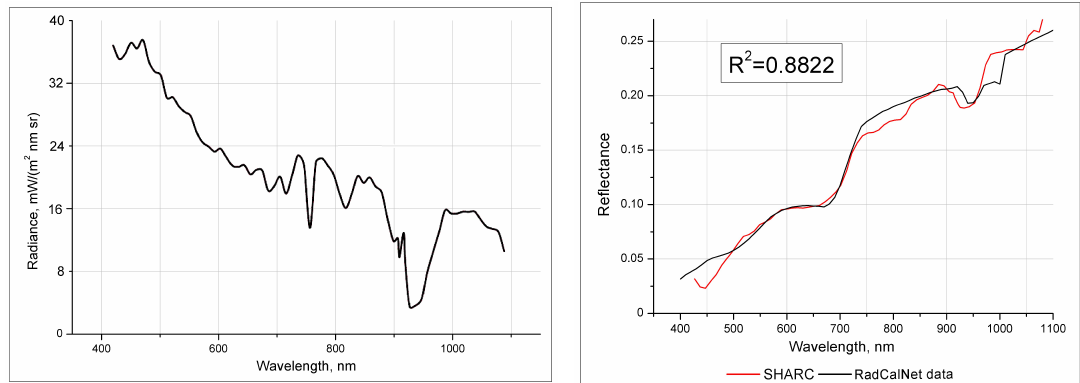
Figure 9. Hyperion radiance spectrum (left side) and measured reflectance of RadCalNet network in comparison with calculated reflectance by SHARC method (right side) for the pixel shown in Figure